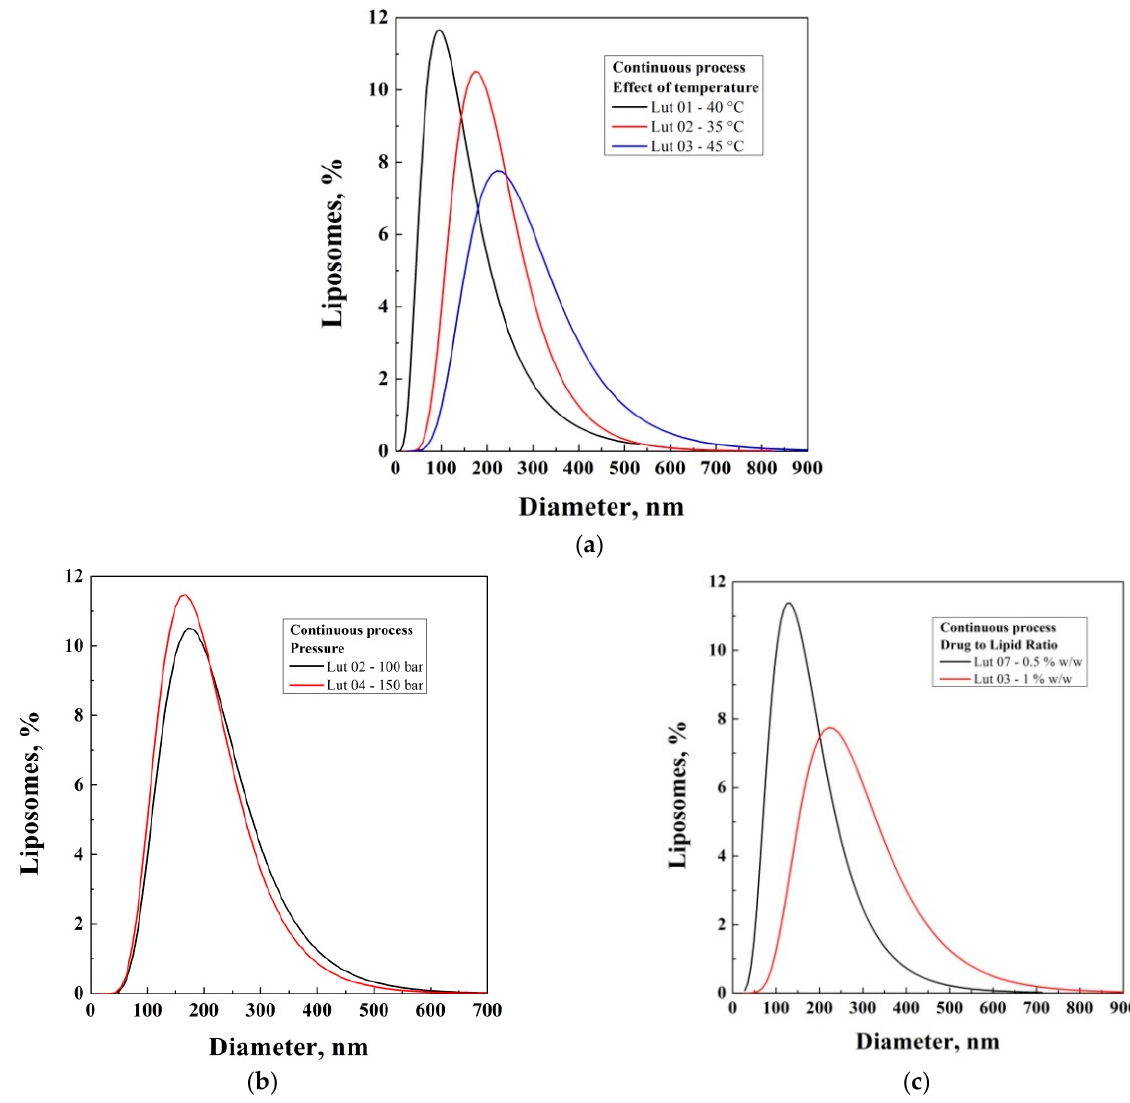
Figure 3. Influence of temperature on liposome mean dimensions for a pressure of 100 bar and a drug to lipid ratio of 1% mass ( a ); influence of operating pressure on liposome size distribution for a drug to lipid ratio of 1% w / w and a temperature of 35 °C ( b ); influence of lutein to lipid ratio on liposome size distribution for a pressure of 100 bar and a temperature of 45 °C ( c ).